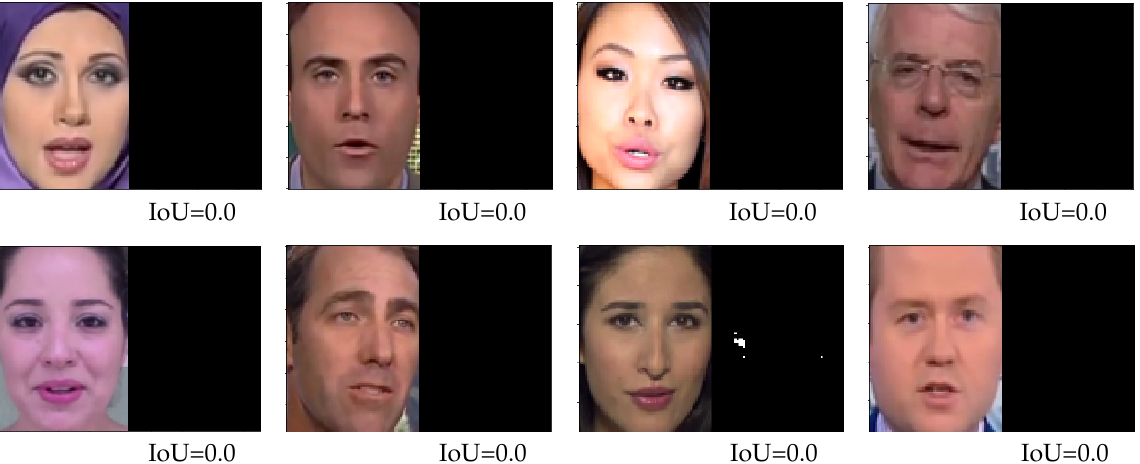
Figure 9. Randomly selected images from the result of detecting the real images by the model trained with the Face2Face dataset. The left side of every pair of sub-images is the fake images and the right side of every pair of sub-images is the prediction